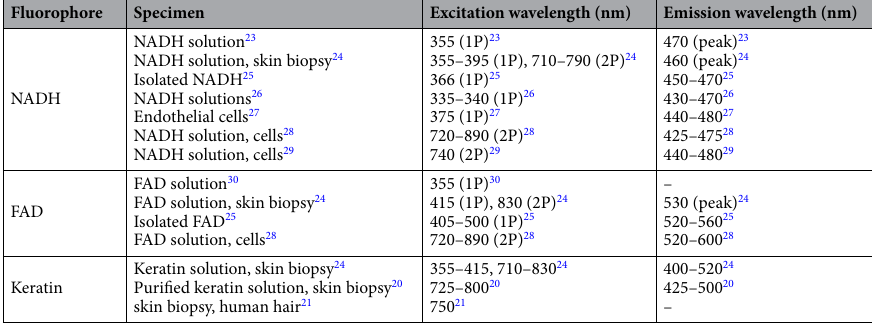
Table 1. Spectral characteristics and lifetime values of intrinsic cellular fluorophores expected in